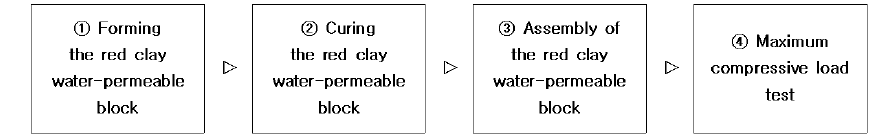
Figure 2. Algorithm of the maximum compressive load test.